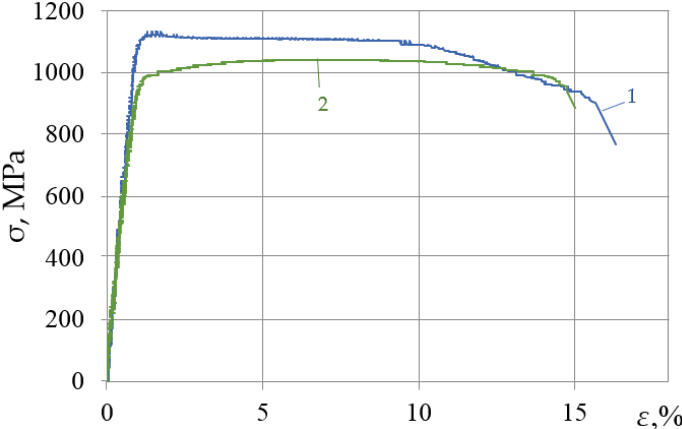
Figure 2. Static tensioning of specimens: 1—longitudinal rolling; 2—transverse rolling.